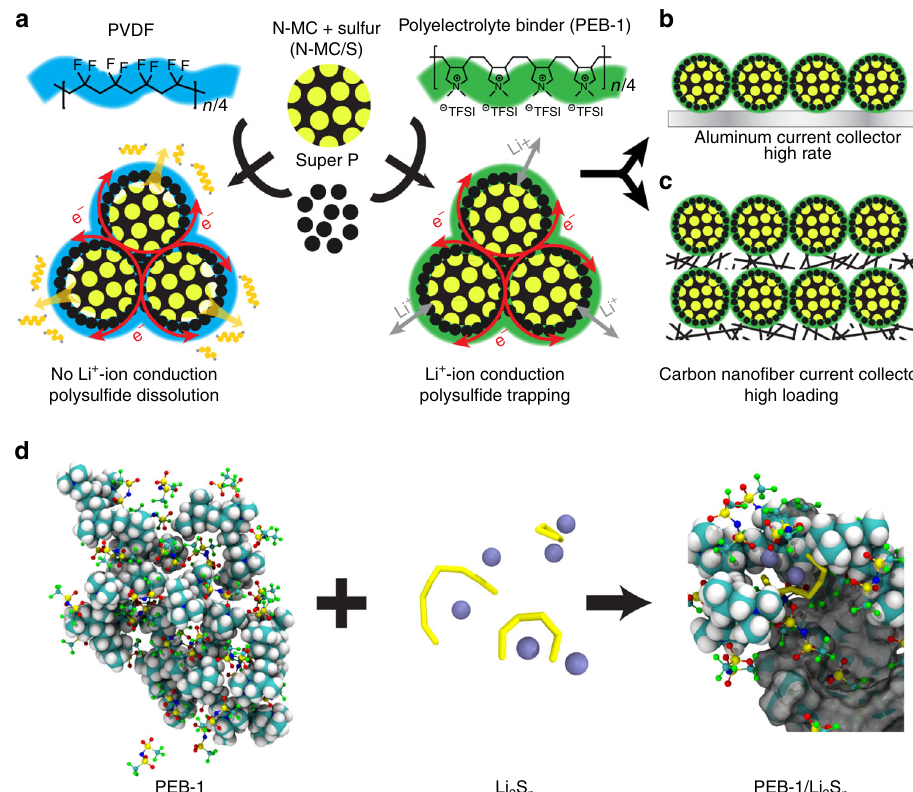
Fig. 1 Illustration of the fabrication of sulfur electrodes with PVDF or PEB-1 binder. a The cathode is comprised of sulfur-active materials loaded into N - doped mesoporous carbon (N-MC) hosts, ‘ Super P ’ as the conductive additive, and a polymer binder (PEB-1 or PVDF). b A conventional sulfur cathode cast onto an aluminum current collector. c A highly loaded sulfur cathode cast onto a carbon nano fi bre current collector. d Schematic illustrating the formation of complex ion clusters via anion metathesis, when PEB-1 encounters soluble polysul fi des during Li – S cell